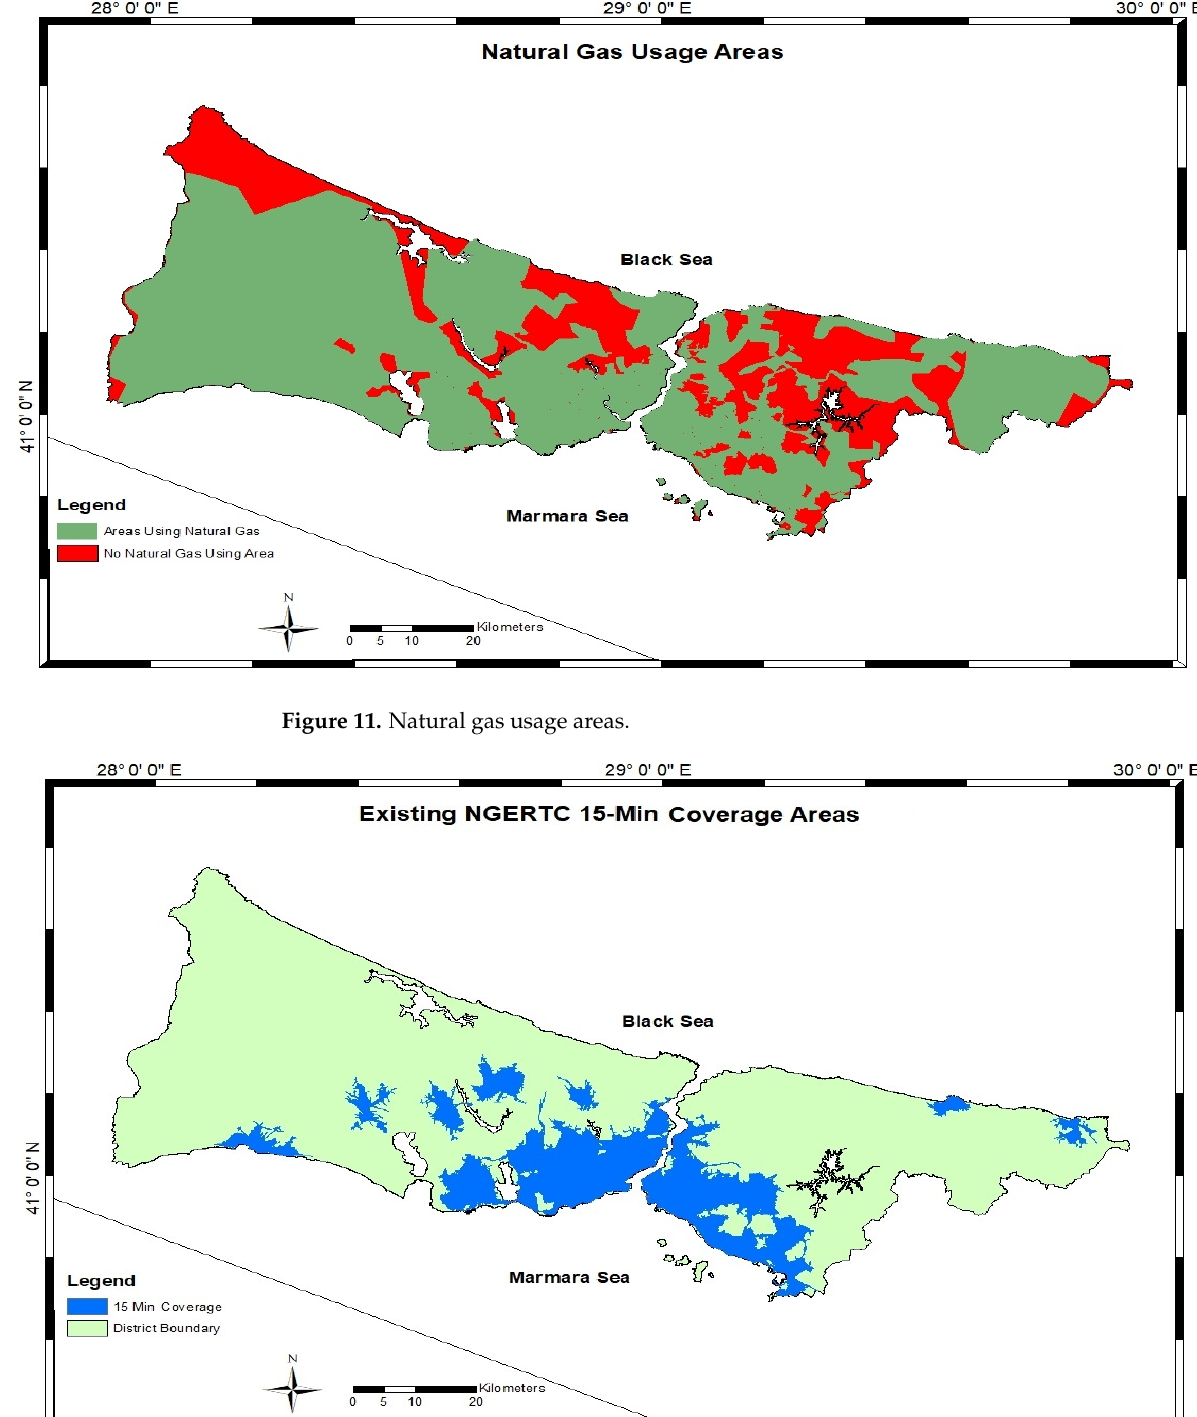
Figure 12. Existing NGERTC 15 min coverage areas.